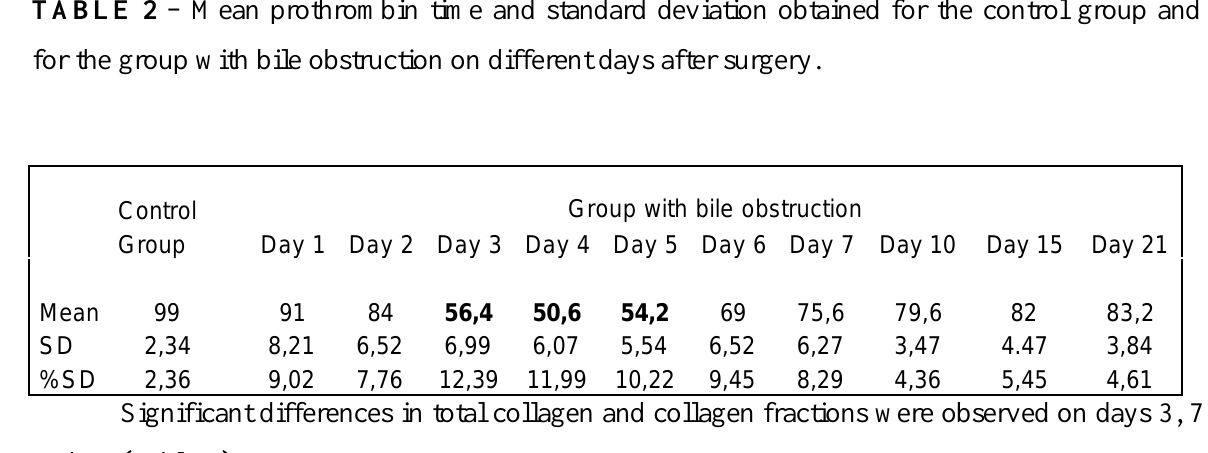
TABLE 2 – Mean prothrombin time and standard deviation obtained for the control group and for the group with bile obstruction on different days after surgery.